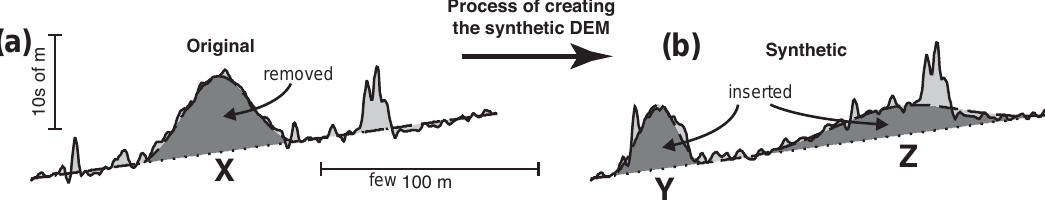
Figure 6. Idealised distance–height profiles to illustrate the process used by Hillier and Smith (2012) to create synthetic DEMs. There are three “components”. Drumlins, which are shaded dark grey, rise above a regional trend indicated by a dotted line. These are overprinted by “clutter” or “noise” shown in light grey. (a) In the process the upper and lower surfaces of the drumlin ( X ) are estimated to define it, and its height is subtracted from the measured DEM. (b) Two Gaussian-shaped drumlins ( Y and Z ) are then inserted by adding their height to create the synthetic